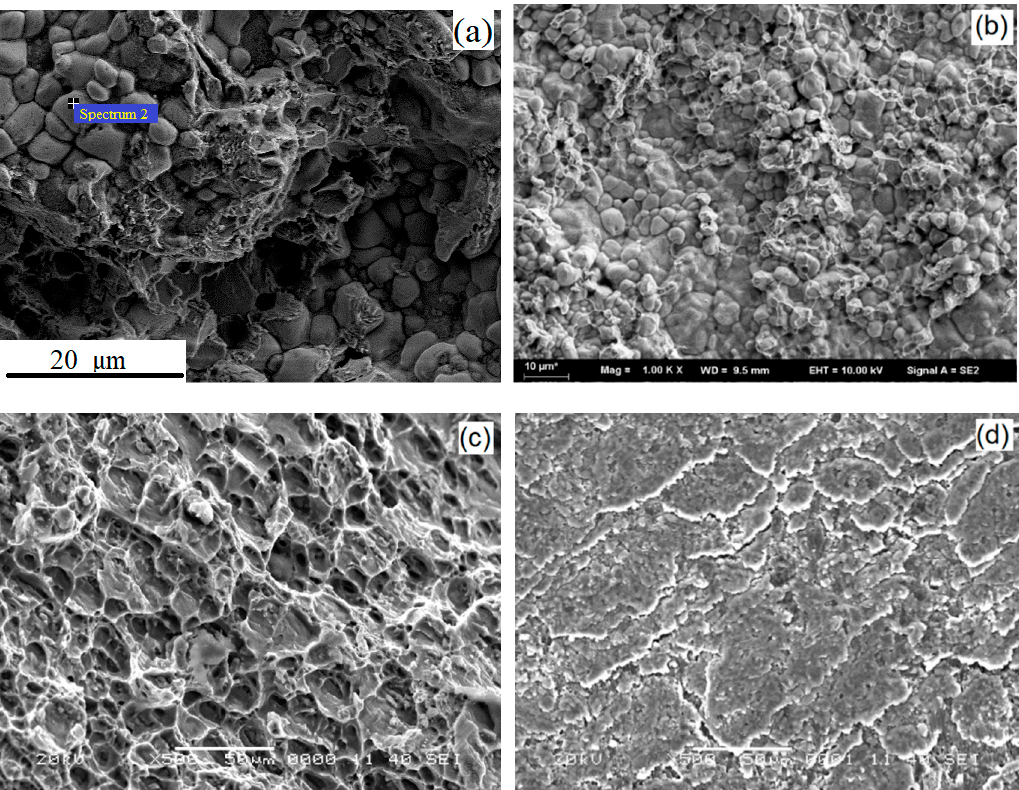
Figure 10. ( a ) No. 4 fracture surface morphology of aluminium side, ( b ) No. 7 microstructure of the steel interface surface after separating the parent metal on the upper and lower sides, ( c ) No. 11 microstructure of aluminium side, and ( d ) No. 16 fracture surface morphology of steel side.